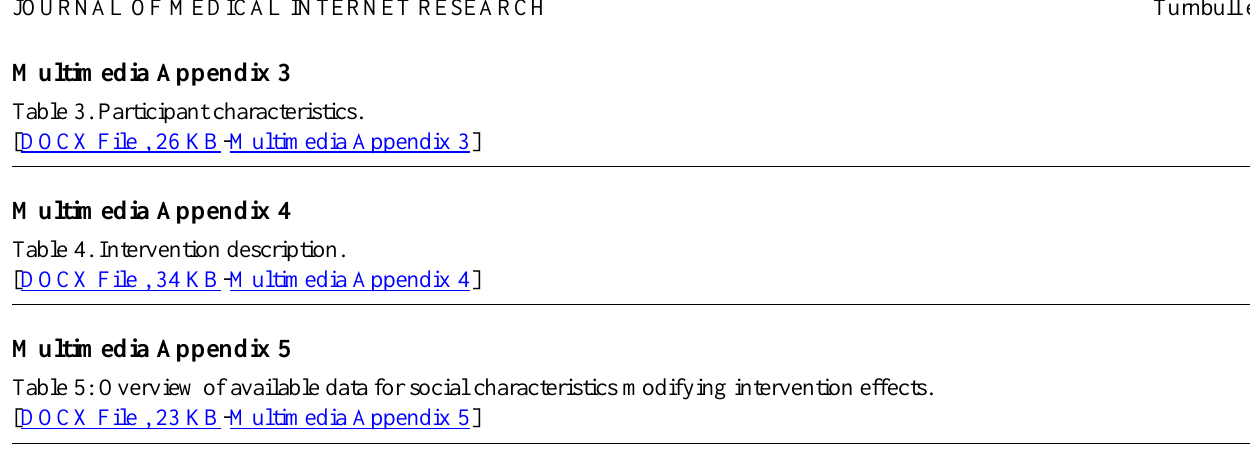
Table 5: Overview of available data for social characteristics modifying intervention effects.